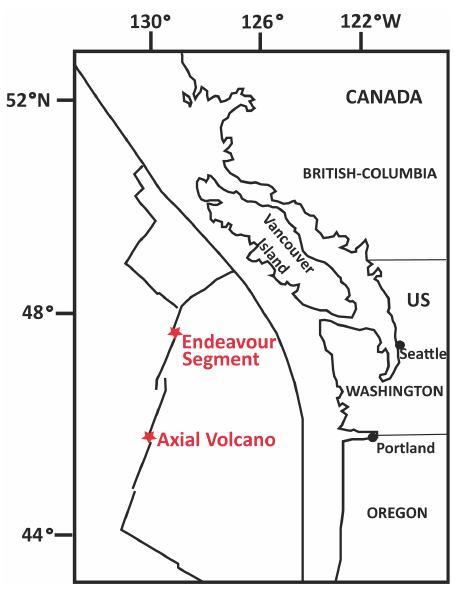
Fig. 1. Map of the hydrothermal vent fields, i.e., Axial Volcano and Endeavour Segment on the Juan de Fuca Ridge (northeast Pacific Ocean), indicated by red stars. See Table 1 for precise location of the sampled vent